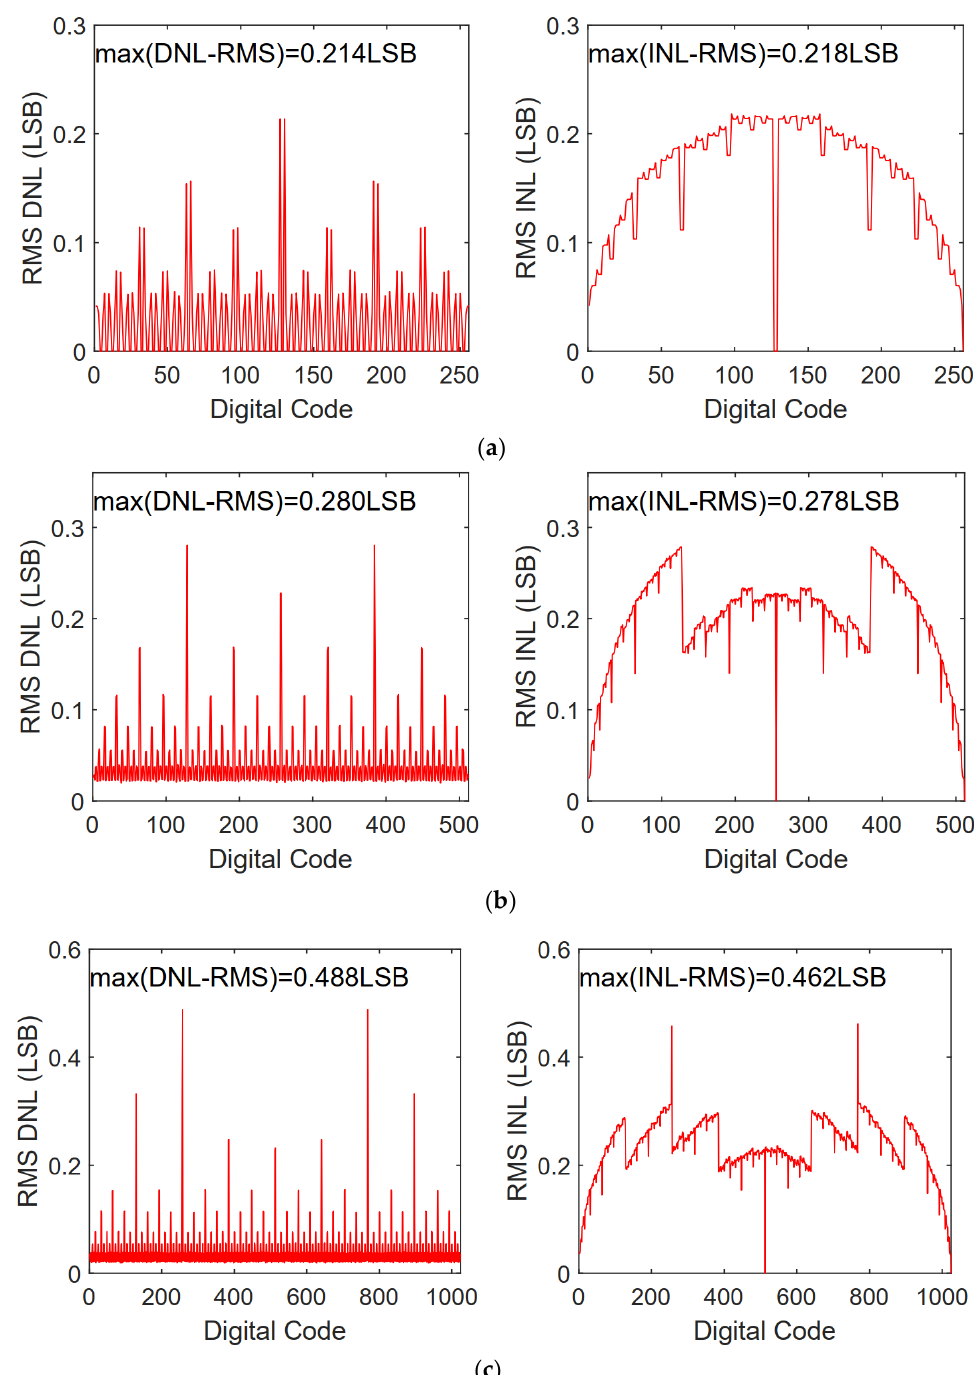
Figure 7. DNL and INL versus output code of the proposed switching scheme: ( a ) 8-bit mode; ( b ) 9-bit mode; ( c ) 10-bit mode. Table 5. Comparison of several switching schemes for SAR ADC.